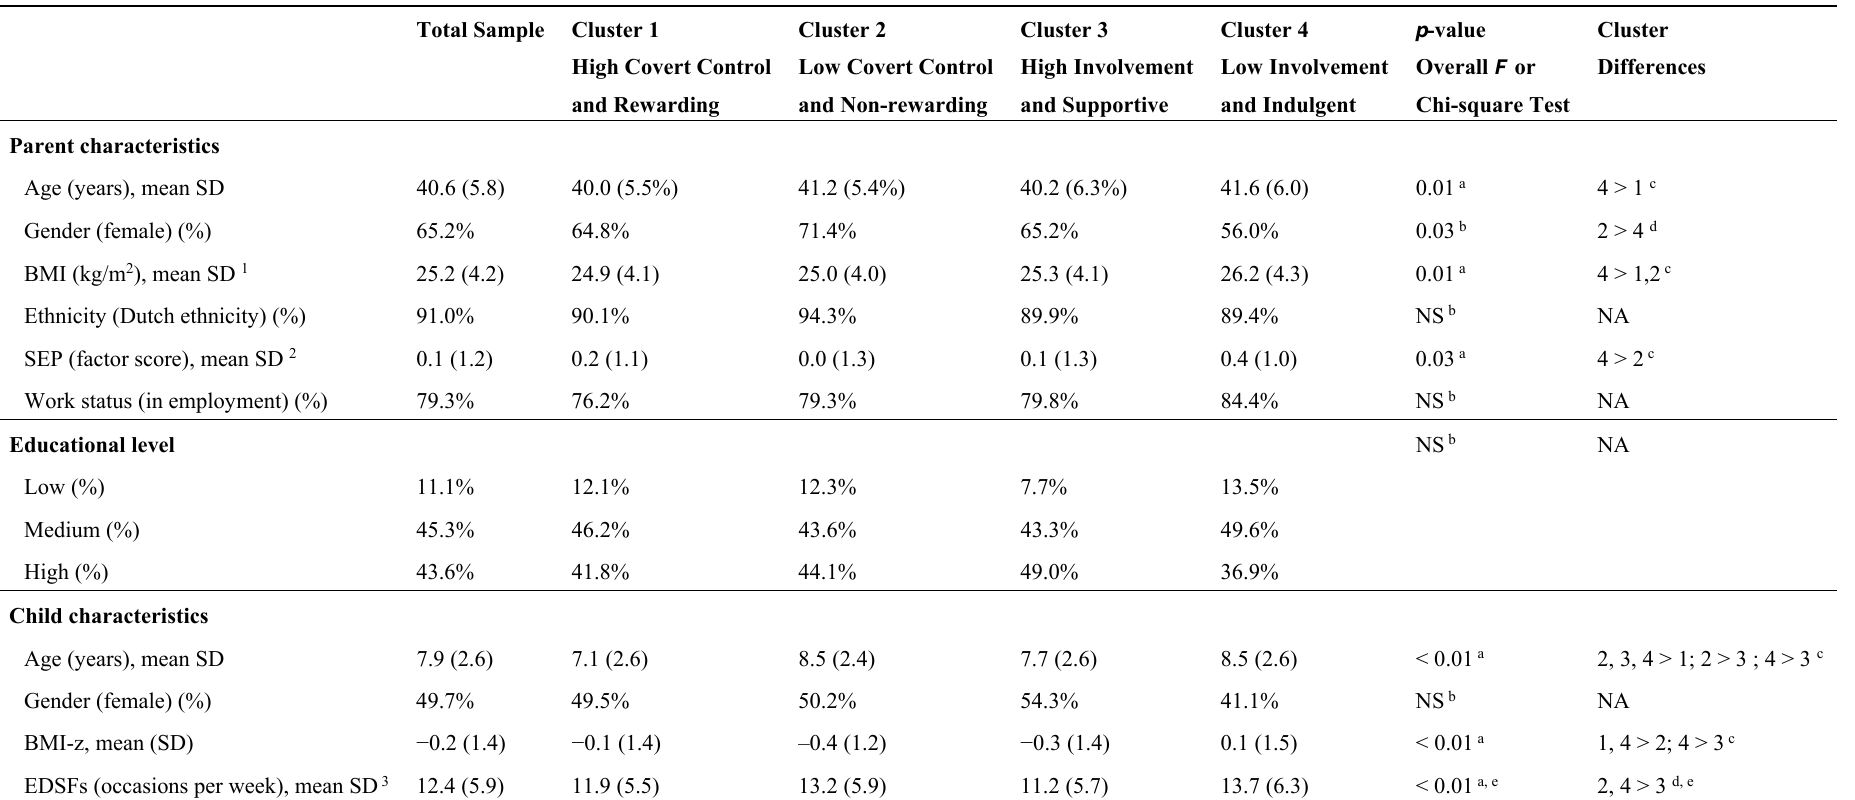
Gender (female) (%) 49.7% BMI-z, mean